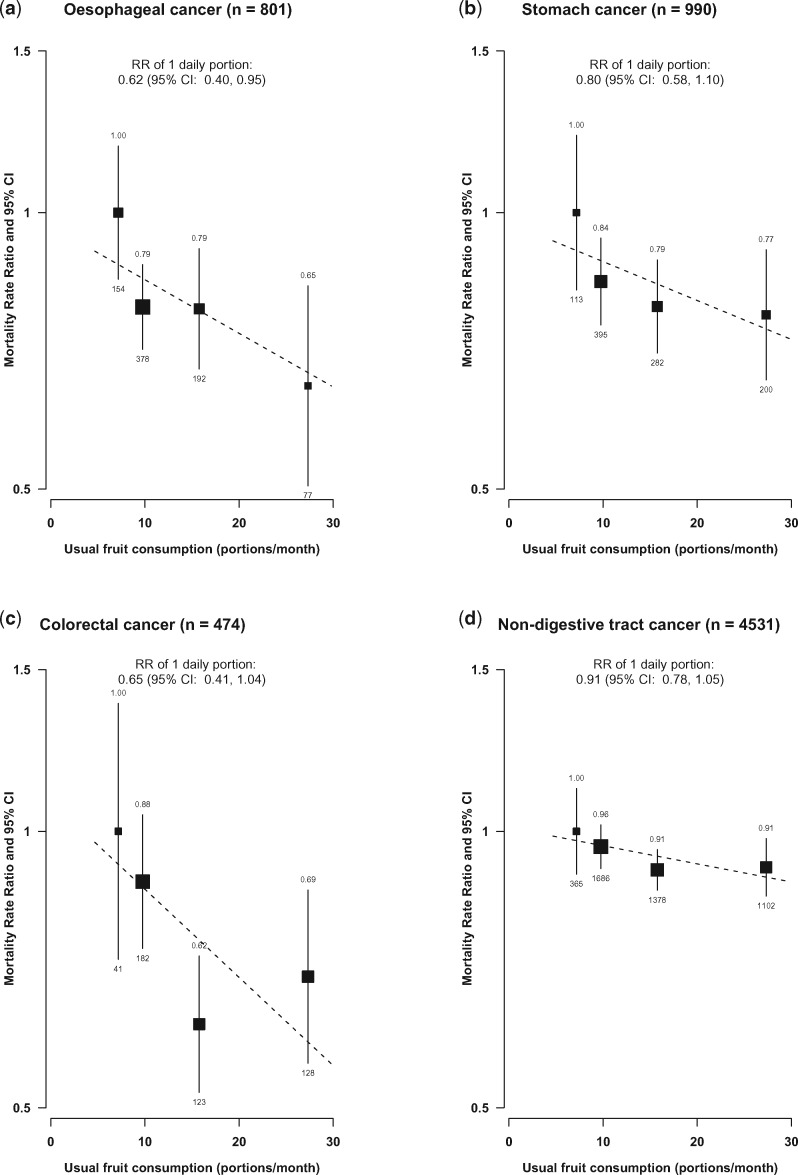
Adjusted RRs for mortality from cancer subtypes by levels of fresh fruit consumption. Conventions as in Figure 2.